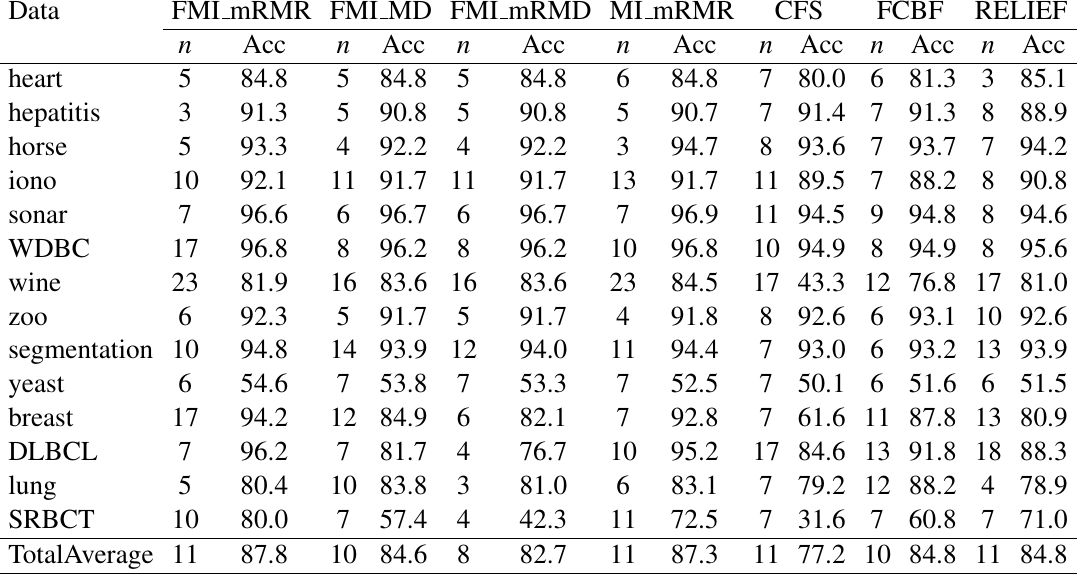
Table 3: Average classification accuracy (%) with four classifiers for different algorithms Data